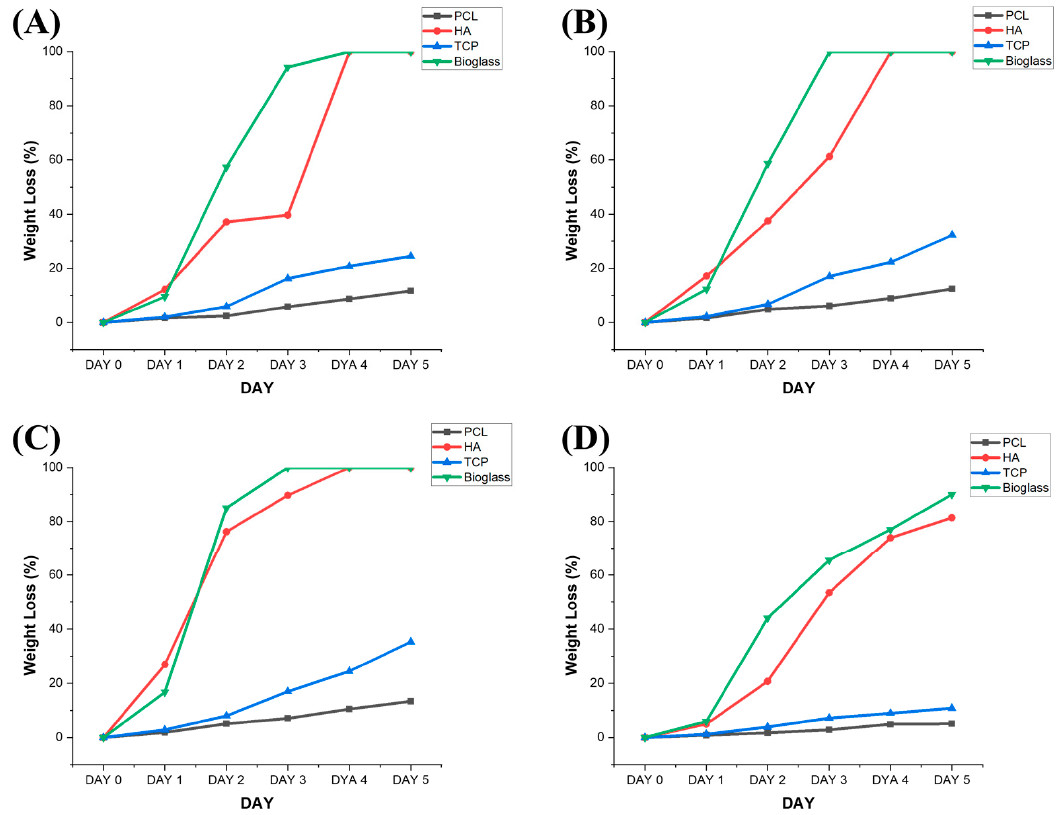
Figure 2. Weight loss as a function of degradation time for different samples and material compositions. ( A ) 200 µ m pore size rectangular scaffolds, ( B ) 300 µ m pore size rectangular scaffolds, ( C ) 500 µ m pore size rectangular scaffolds and ( D ) bone bricks.